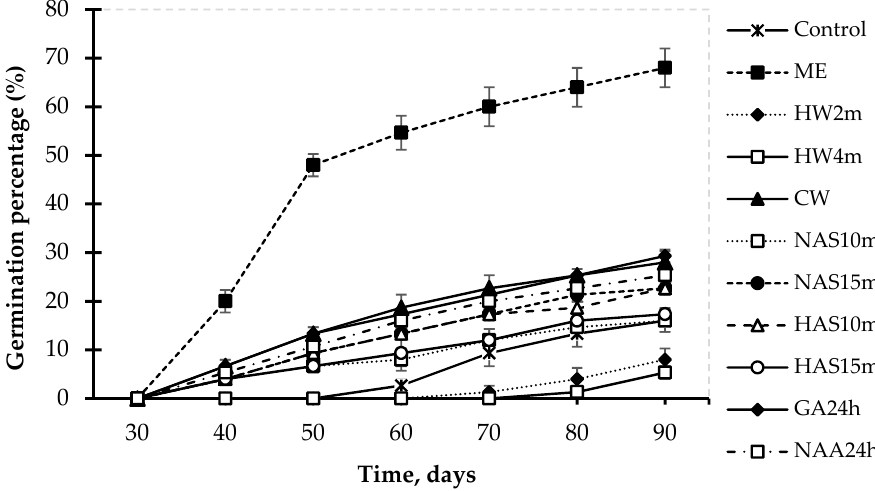
Figure 4. In vitro black cardamom seed germination patterns under different treatments.